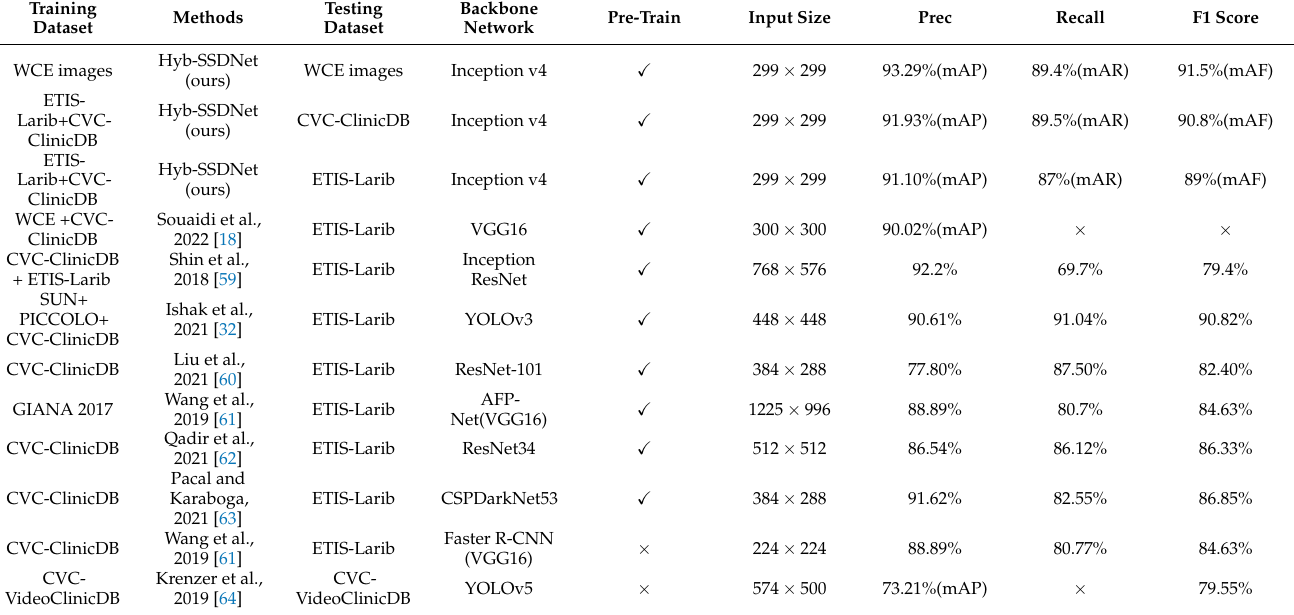
Table 3. WCE or colonoscopy test detection results, or both (IOU > 0.5, batch-size